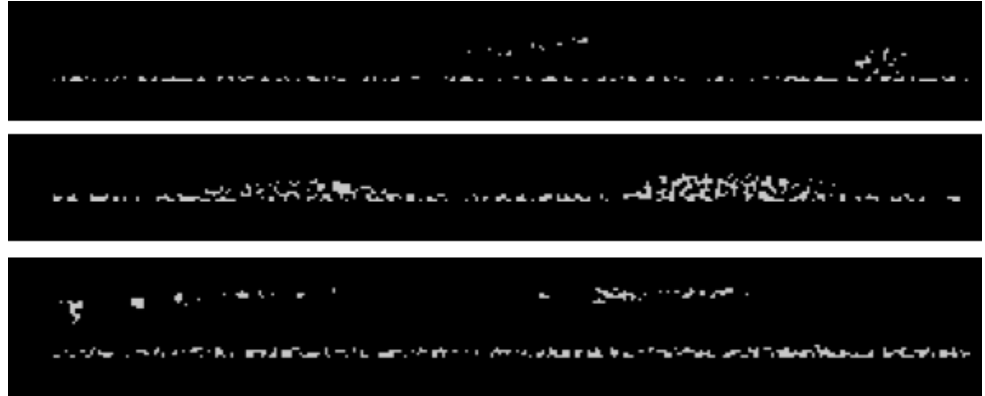
Figure 2. Data from Figure 1 after going through an 2 × 2 erosion filter.